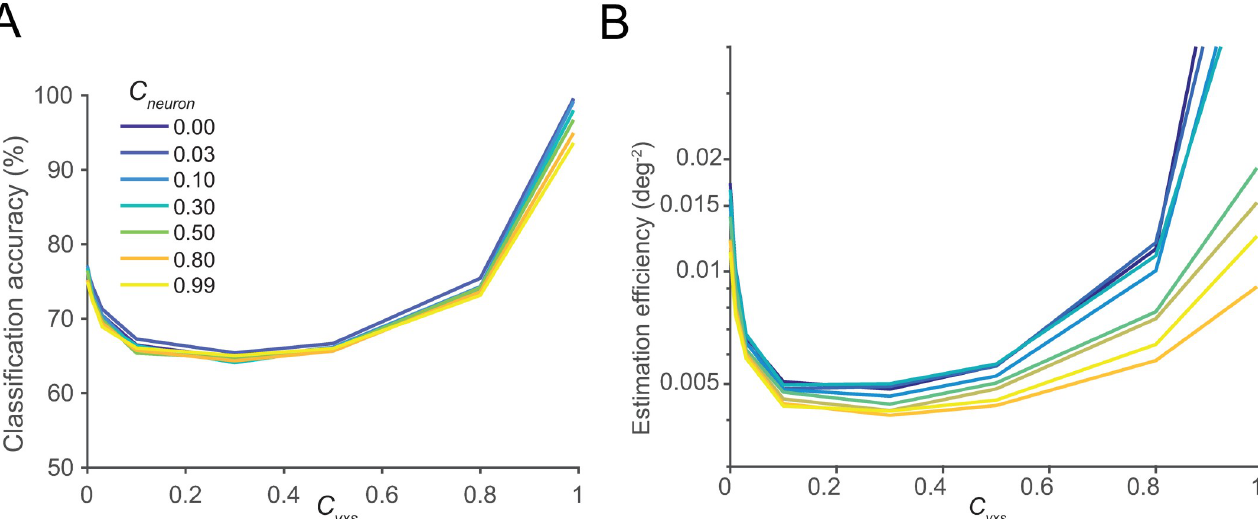
Fig 6. The impacts of neuronal and voxelwise cTCNCs on stimulus classification (A) and estimation (B). In both tasks, decoding performance exhibits U-shaped ). Neuronal cTCNCs (i.e., c ) have small impacts on classification accuracy, because the voxel-level functions of the strength of voxelwise cTCNCs (i.e., c vxs neuron noise primarily limits information. Neuronal cTCNCs have a more prominent detrimental effect in the estimation task. These results are consistent with the results when two levels of cTCNCs are manipulated independently.